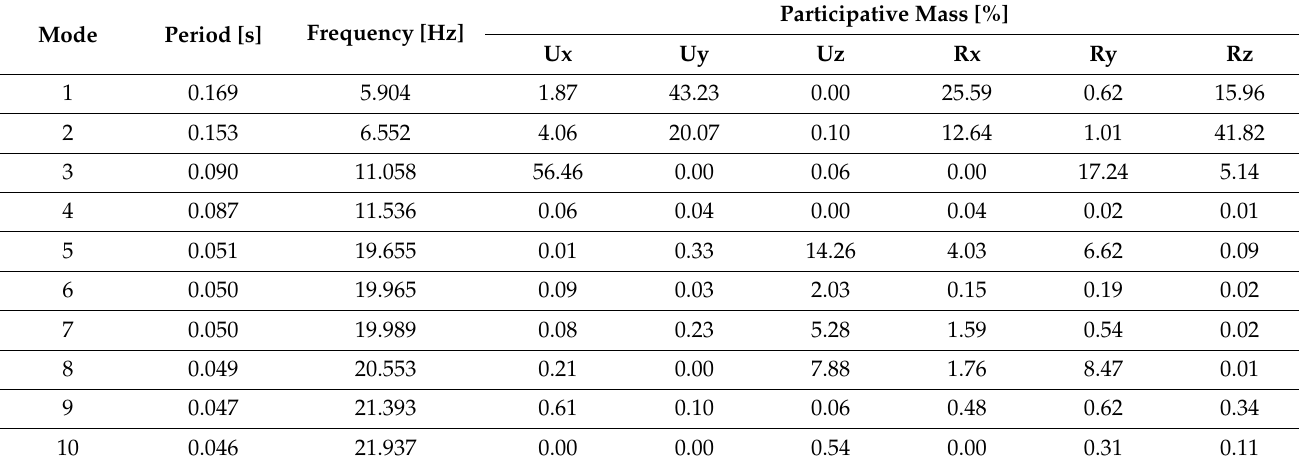
Table 2. First ten modes characteristic of the